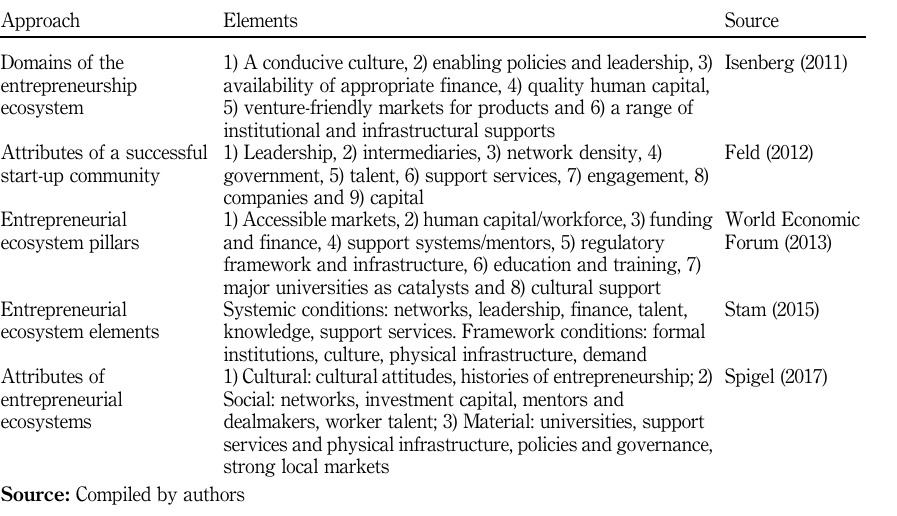
Table II. Elements